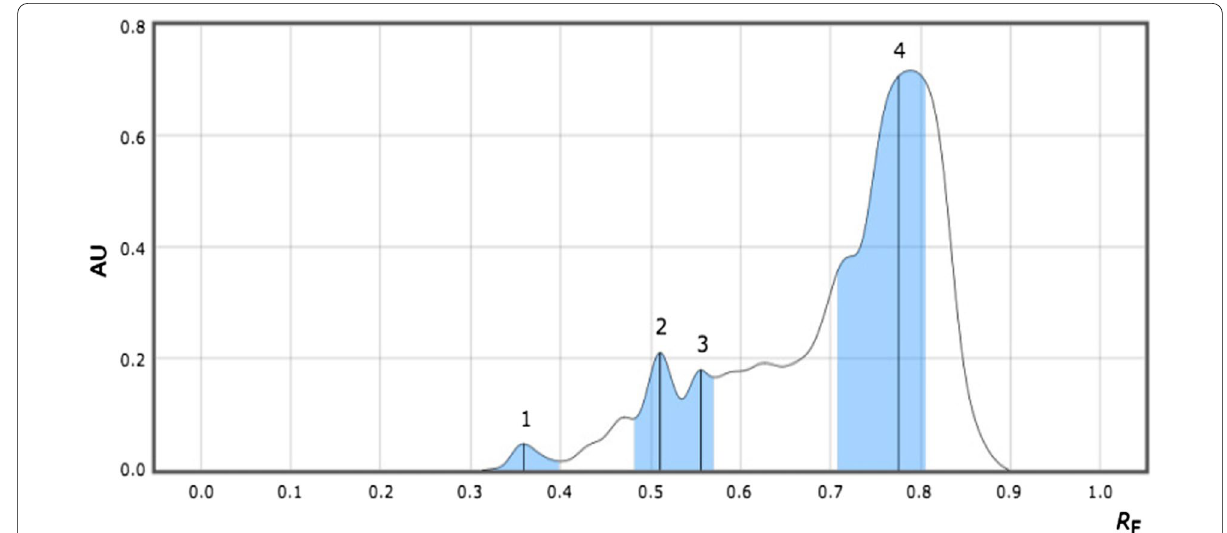
Fig. 4 HPTLC spectrum peak chromatogram of the ethanolic extract of K. galanga